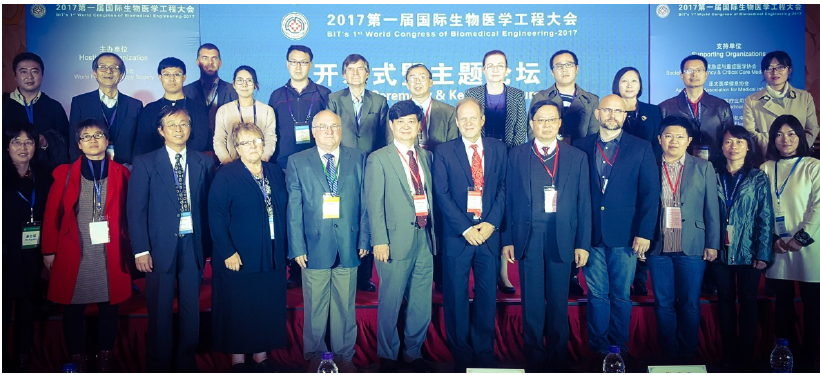
Figure 1. Keynote Forum of the “BIT’s 1st World Congress of Biomedical Engineering 2017”.